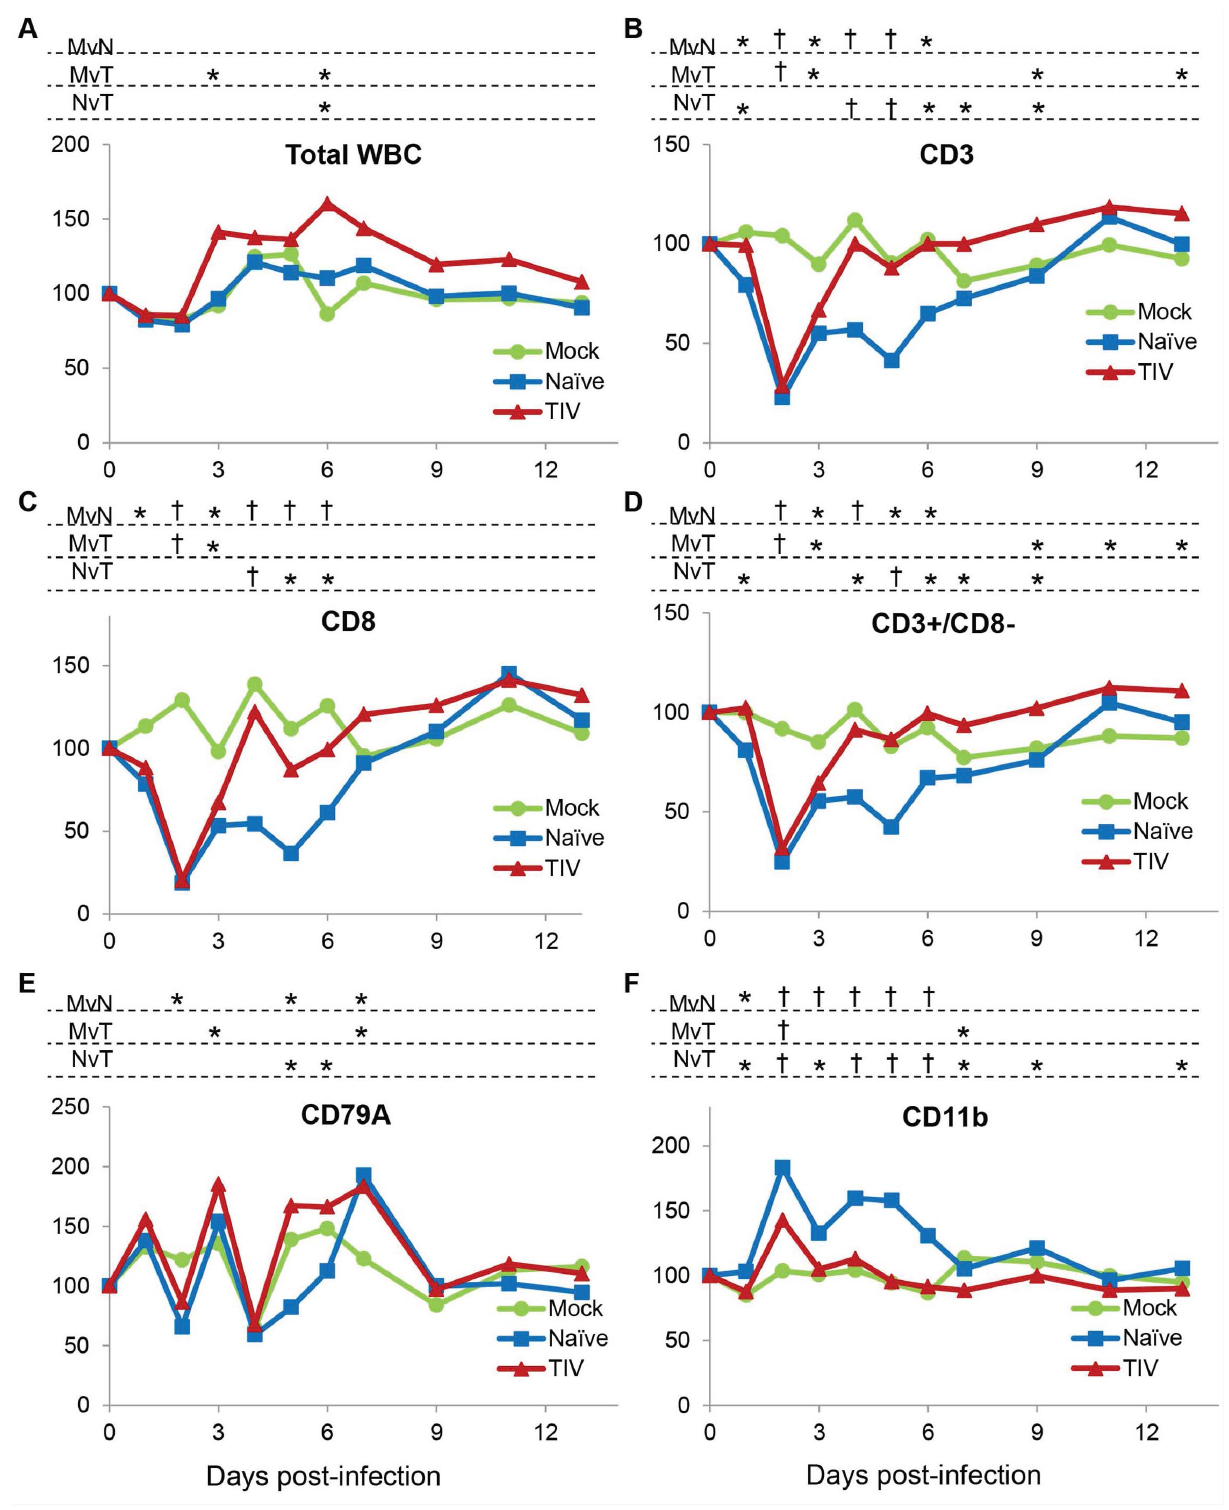
Figure 4. Peripheral blood leukocyte subsets following infection of vaccinated and naı¨ve animals with Perth/16. Ferrets were bled on days 0–7, 9, 11, and 13 relative to the day of viral challenge, and cells were stained and analyzed by flow cytometry as described in the text. ( A ) Total white blood cell counts were obtained using a Hemavet apparatus. Percentages of ( B ) CD3-positive cells (T cells), ( C ) CD8-positive cells (cytotoxic T lymphocytes), ( D ) CD3-positive cells (T cells) and CD8-negative cells, ( E ) CD79a-positive cells (B cells), and ( F ) CD11b-positive cells excluding CD11b- high/FSC-high cells (granulocytes) were measured. For each animal the frequencies were normalized to the ferret’s values on day 0; the Y axis represents percent of values on day 0. ‘‘Mock’’, unvaccinated mock-infected animals; ‘‘Naı¨ve’’, unvaccinated animals challenged with Perth/16; ‘‘TIV’’,